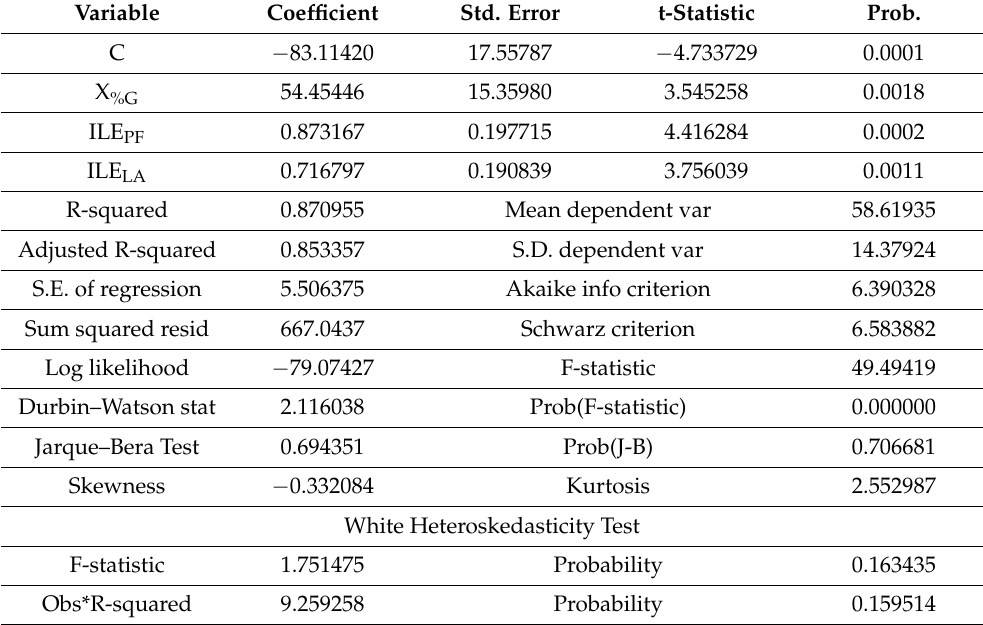
Table 7. S FDI_in(%GDP) model by X %G , ILE PF and ILE LA for